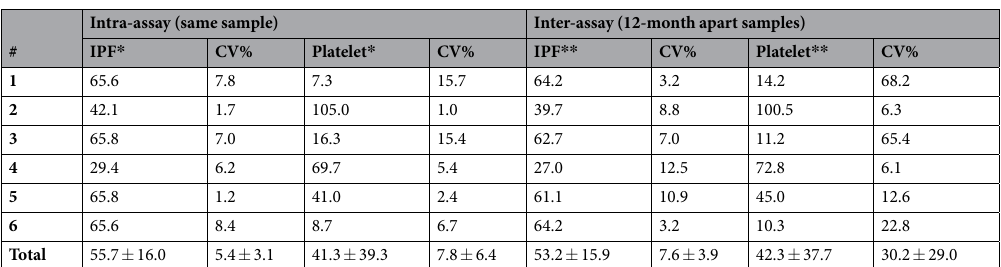
Table 3. Reproducibility of IPF measurements in patients with HM. Intra-assay reproducibility was measured by 3 sequential measurements of IPF% in the same sample, with * indicating the mean of these 3 results. The inter-assay reproducibility was measured by repeating the IPF% in the same patient after 12 months, with ** indicating the mean of these 2 results. Total represents the mean and SD of six